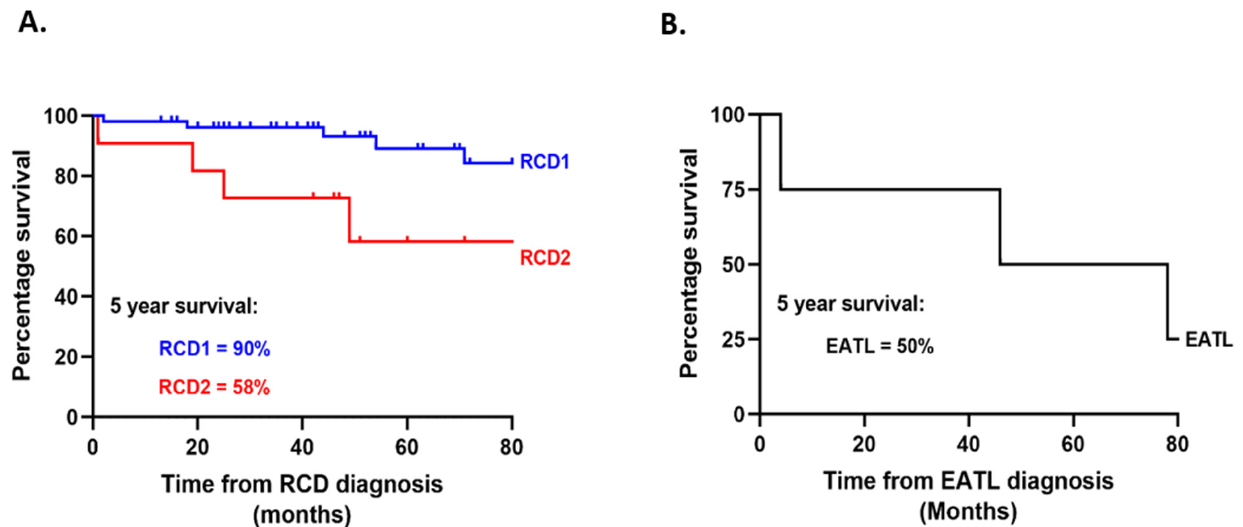
Figure 3. ( A ) Survival analysis in RCD1 and RCD2. The estimated 5-year survival in RCD1 was 90% and RCD2 was 58% ( p = 0.016); comparison was analysed using the log–rank test (Mantel–Cox method). ( B ) Survival analysis in all patients with EATL (one secondary EATL; three de novo EATL). The estimated 5-year survival in EATL was 50%.